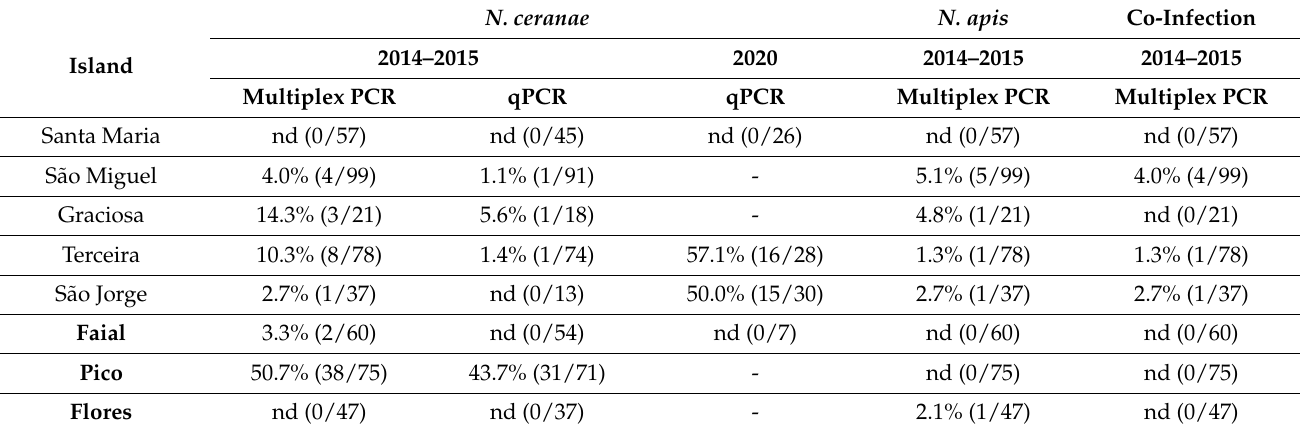
Figure 2. N. ceranae prevalence result of multiplex approach in 2014/2015. Table 2. Prevalence of N. ceranae ; N. apis; co-infection by sampling year and molecular method. The number of positive samples and sample sizes are shown within parenthesis for each island. Islands with V. destructor are represented in